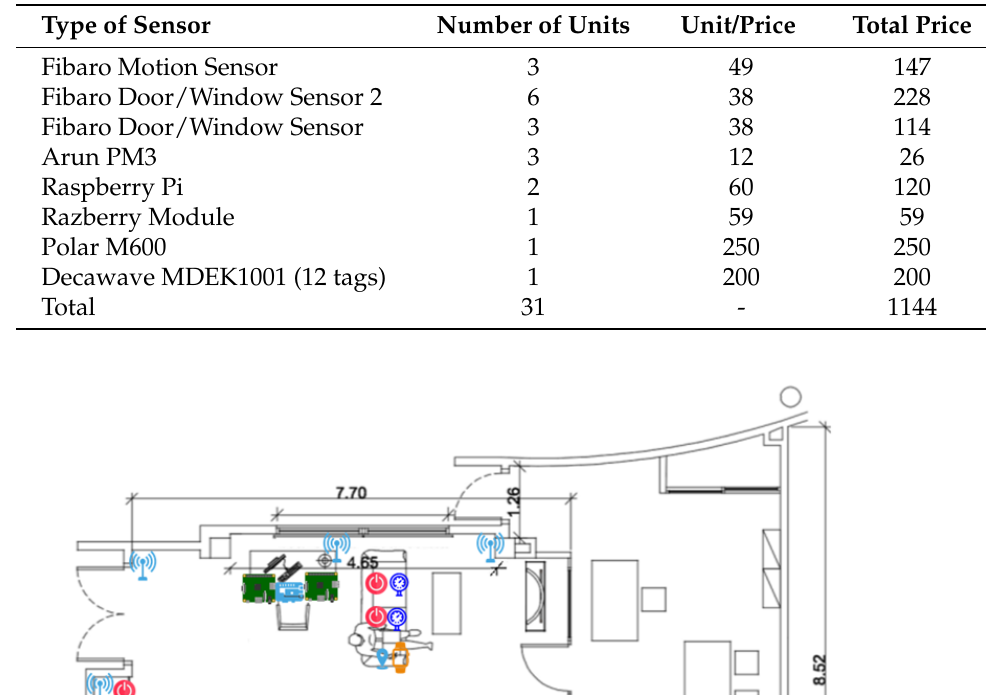
Table 1. Total price of the system.